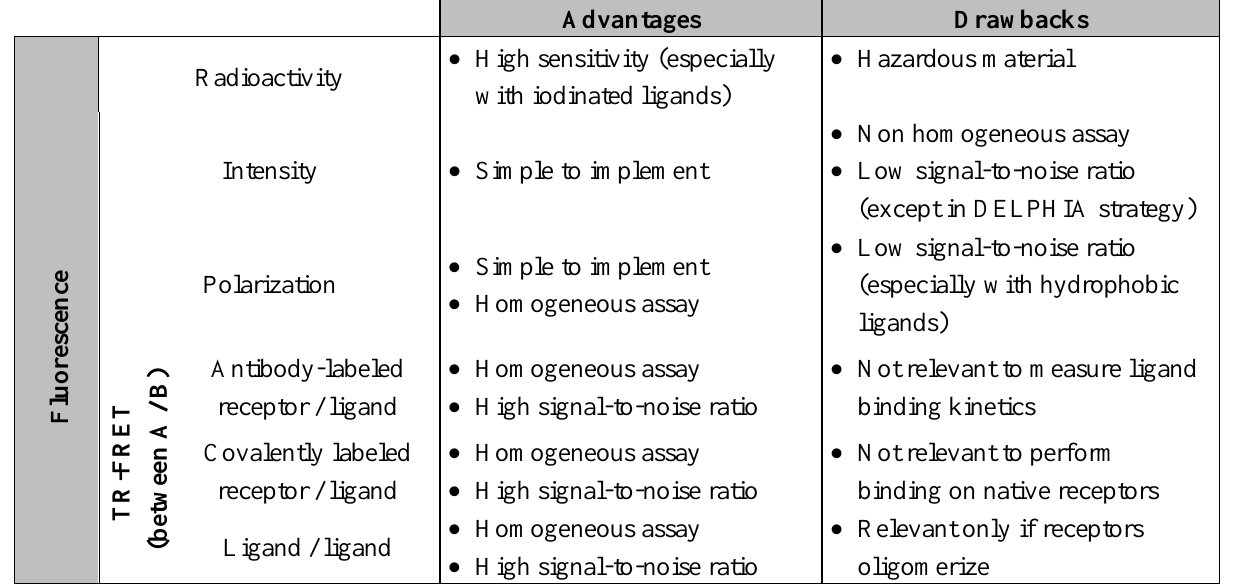
Table 1. Advantages and drawbacks of different binding assays presented in this